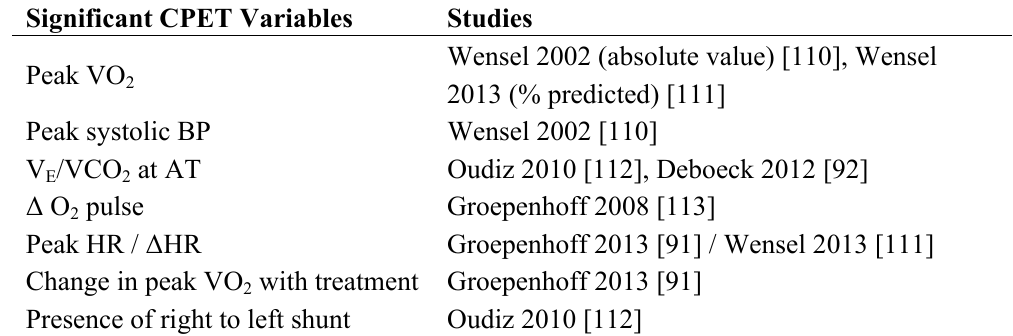
Table 2. Studies of prognostic value of CPET variables in PAH subjected to multivariate analysis.